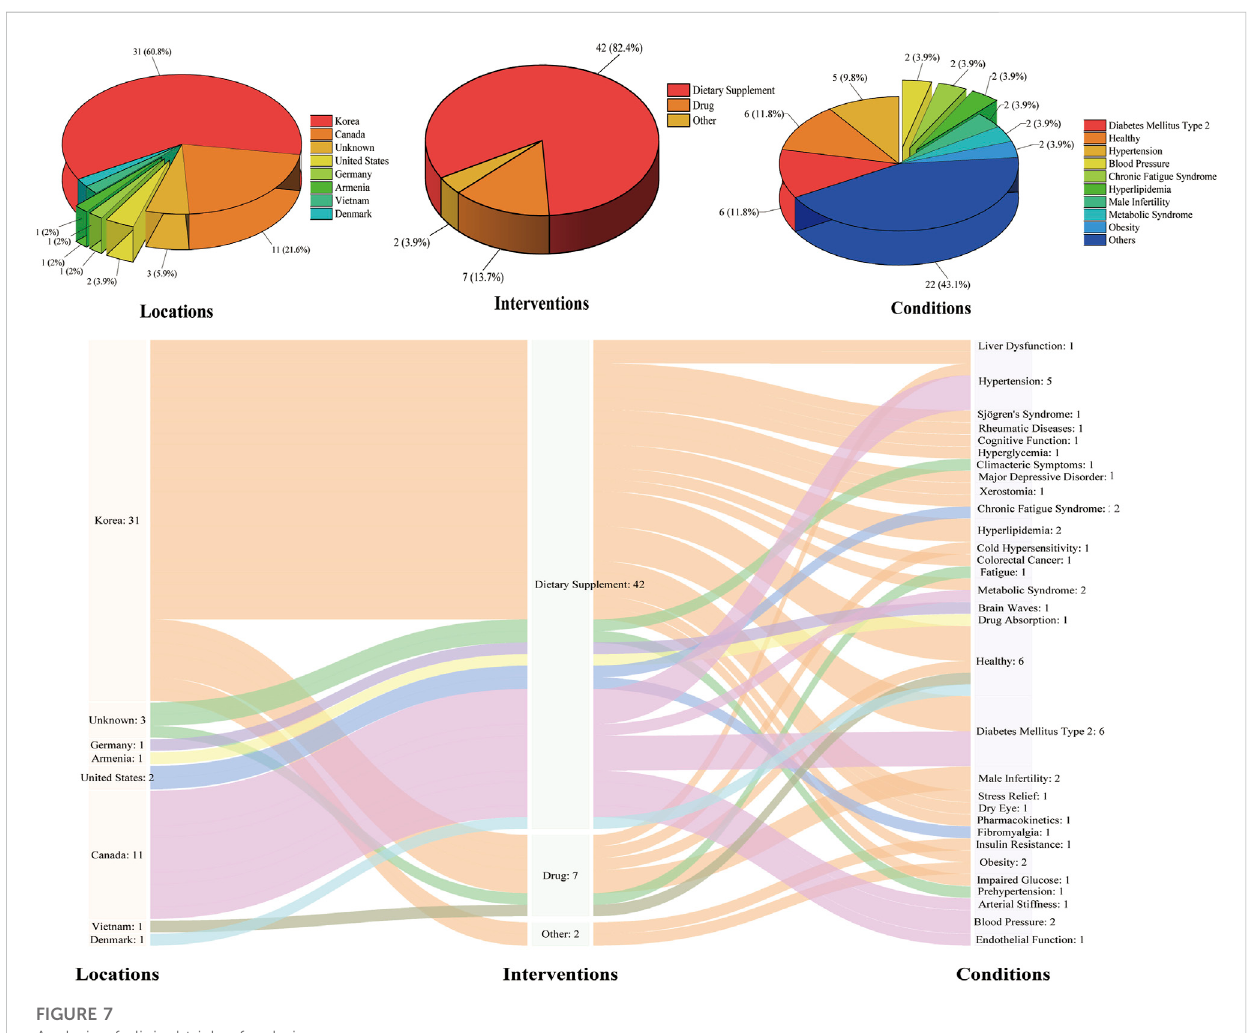
FIGURE 7 Analysis of clinical trials of red